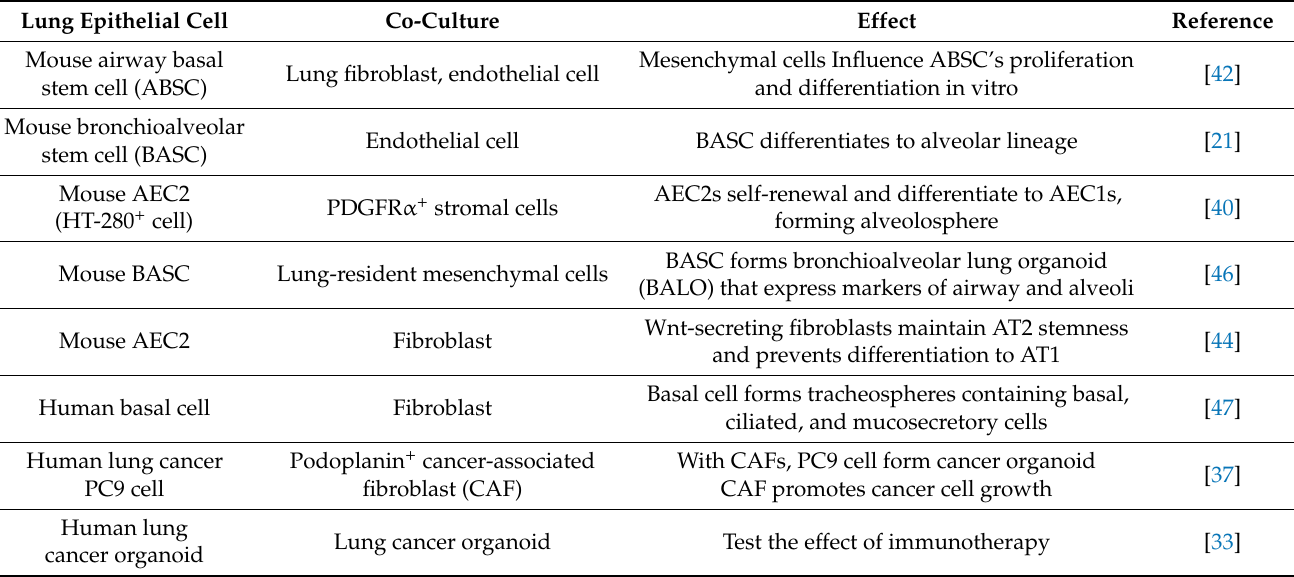
Table 3. Co-culture with organoids from mouse adult stem